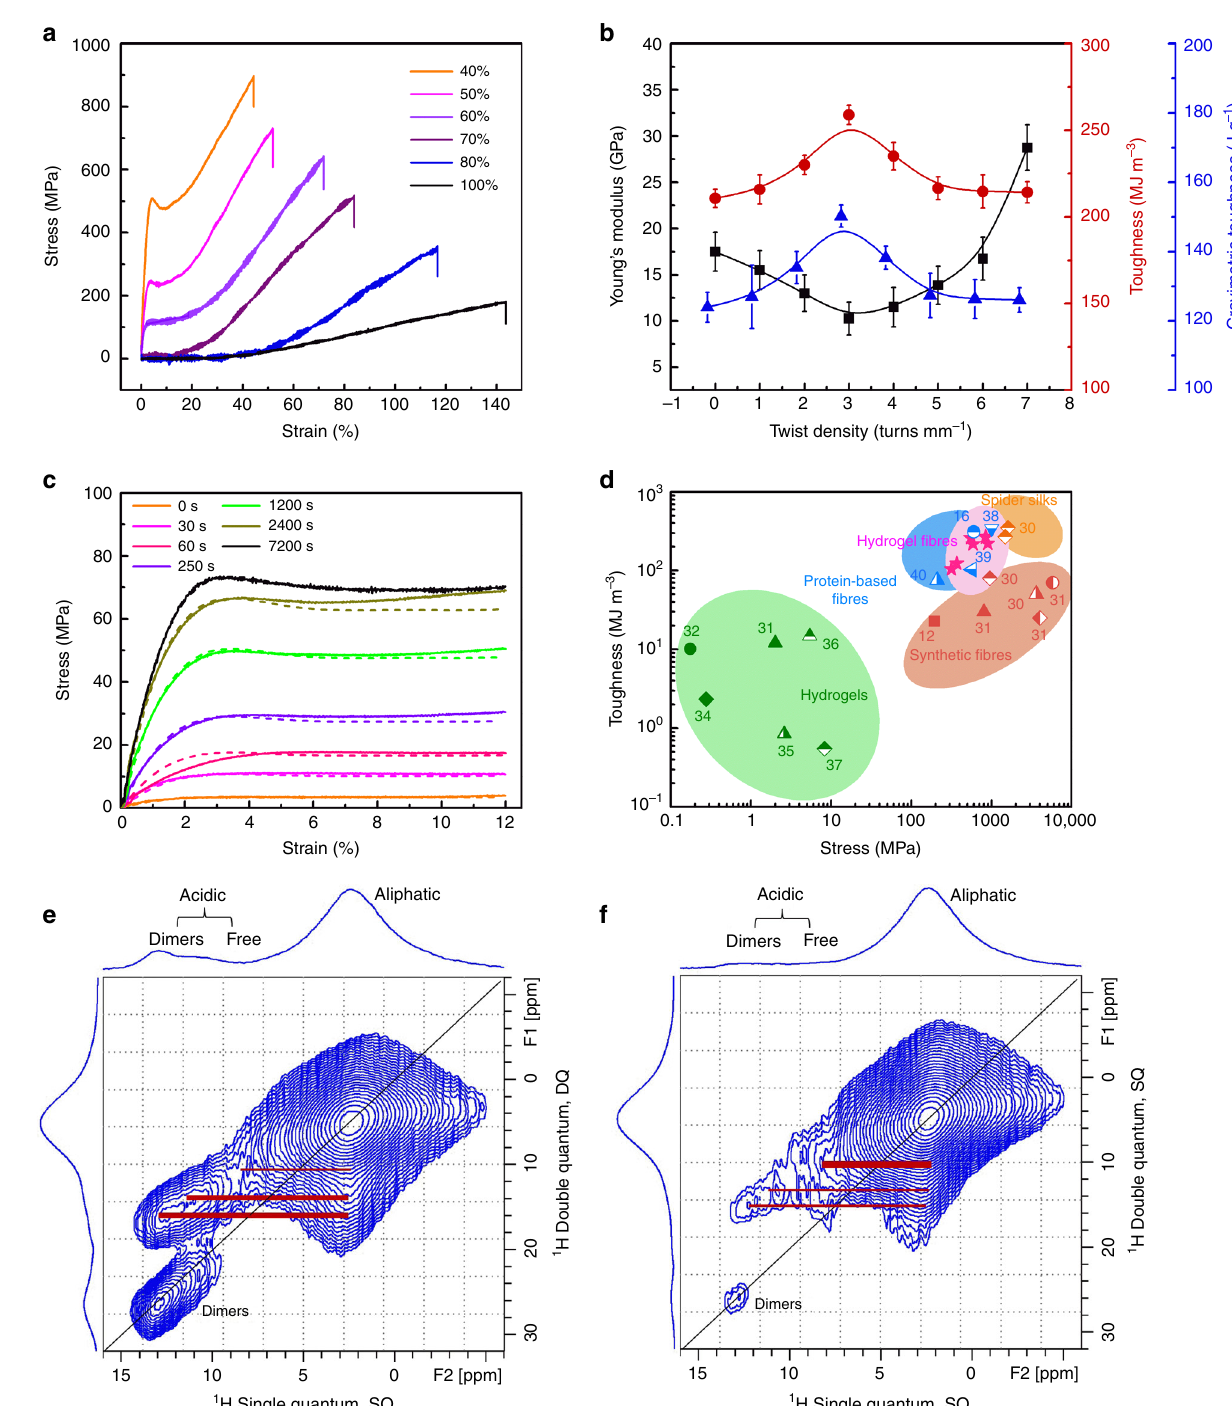
Fig. 2 Modelling of the mechanical properties and toughness of the hydrogels. a Tensile stress-strain curves of hydrogel fi bres with optimised mechanical properties under different humidity values. The twist density was 7 turns mm − 1 , and the deformation rate was 27.8% s − 1 . b The Young ’ s modulus, toughness, and gravimetric toughness of the hydrogel fi bres as a function of the twist density. The deformation rate was 27.8% s − 1 . c FEM simulation results of the engineering stress-strain curves of the hydrogel fi bres (dotted line) with the same diameter (50 μ m) but different drying times; the solid curves represent the experimental data. d Comparison of the energy dissipation and damping capacity of hydrogel fi bres (pink stars) in this work with those of other typical energy-dissipation materials, such as hydrogel (green symbols), spider silk (yellow symbols), protein-based fi bres (blue symbols) and synthetic fi bres (red symbols), reported in the literature. The numbers shown in the graphs correspond to the references. The hydrogel fi bres presented different twist densities and were tested at different deformation rates. All the hydrogel fi bres contained 0.1 wt% VSNPs and 20 mM ZnCl 2 . e, f The 1 H double-quantum/single-quantum (DQ/SQ) chemical shift correlation spectra at 40 kHz MAS of samples: e without and f with ZnCl 2 . Two rotor periods of Back-to-Back (BABA) recoupling were used for the excitation and reconversion of the DQ coherence. The error bars mean the s.d. from fi ve measurements